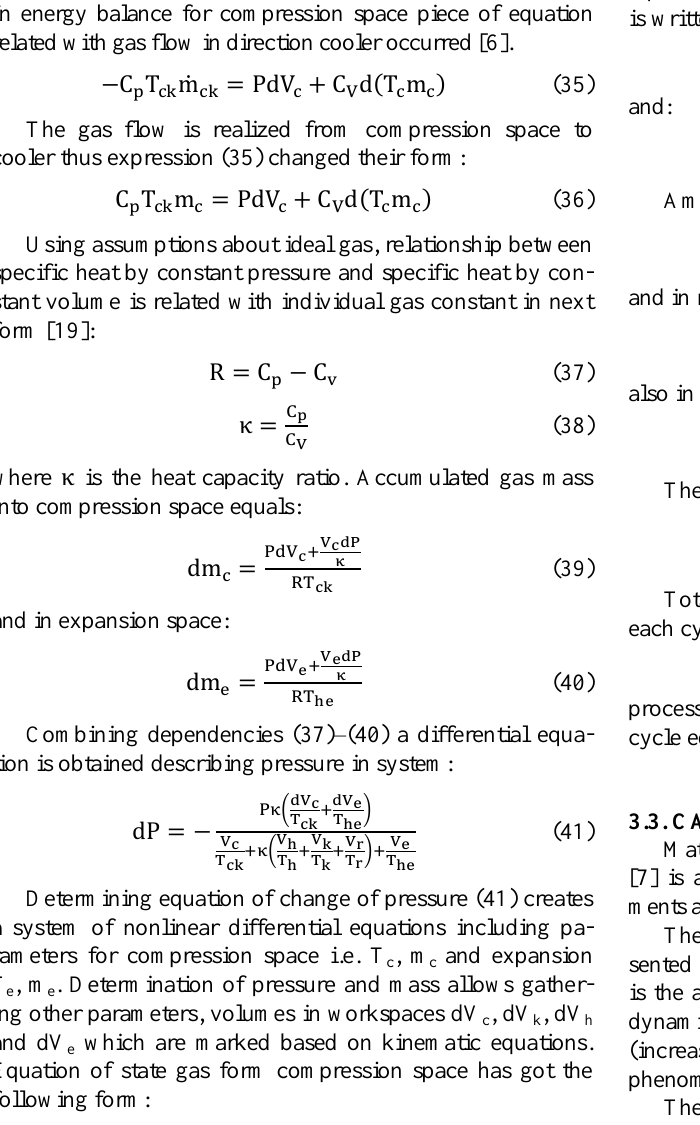
Fig. 12. Scheme of adiabatic compression space and cooler [22] Compression space is insulated to environment and hence – form of change of internal energy took place only for